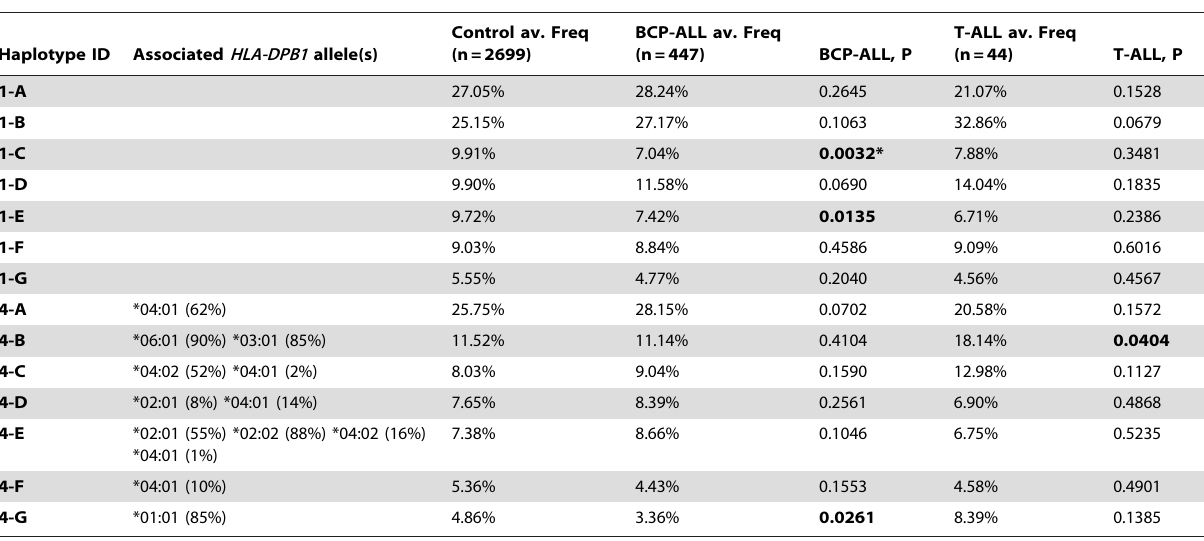
Haplotype ID Associated HLA-DPB1 allele(s)